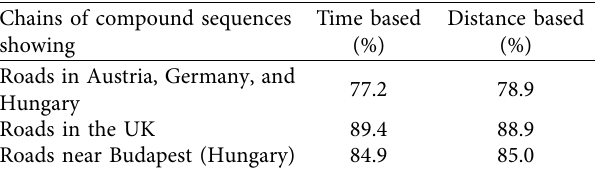
Time based Distance based (%) (%) 77.2 78.9